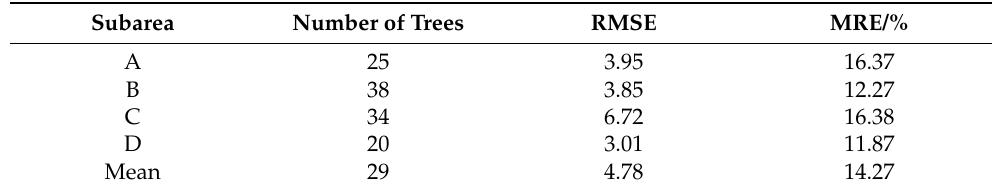
Table 2. Extraction accuracy of crown area using U 2 -Net model.